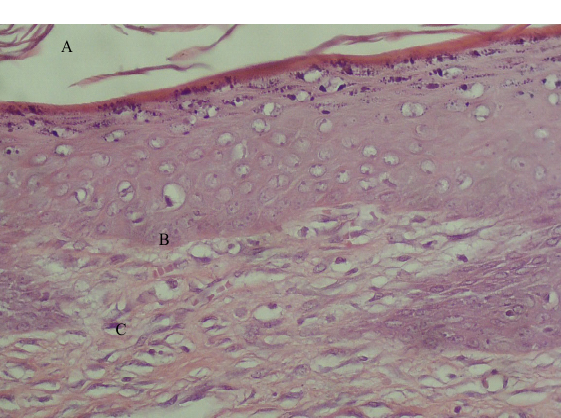
FIGURA 14 - Fotomicrografia do grupo controle do 21º dia. Nota: Reepitelização completa (A) e grande quantidade de colágenos (B) (Tricômio de Masson com aumento de 40x)